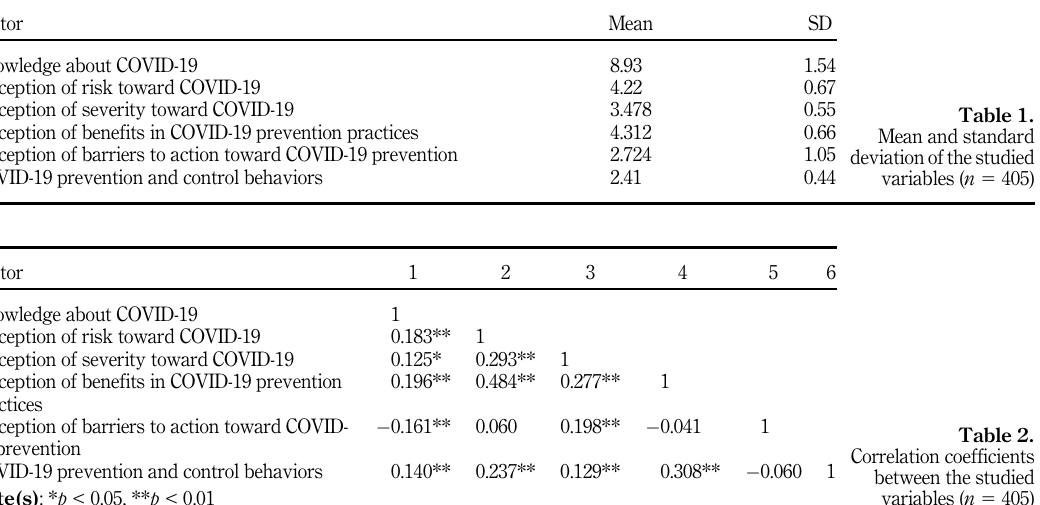
between the studied variables ( n 5